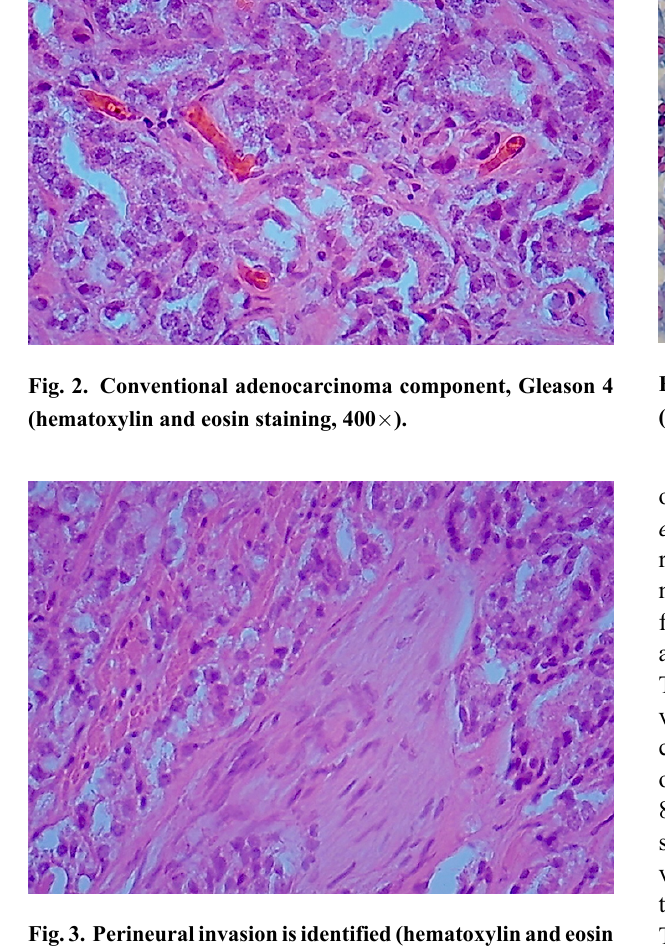
Fig. 3. Perineural invasion is identified (hematoxylin and eosin staining, 400 × ).